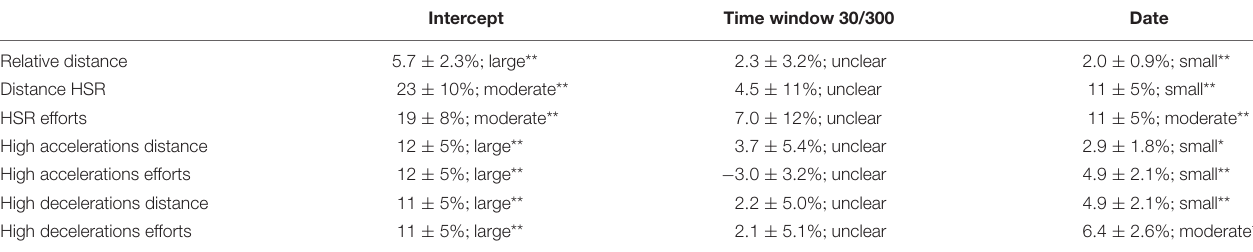
TABLE 3 | Random effects (standard deviations) representing individual differences in player means and slopes, and differences in game